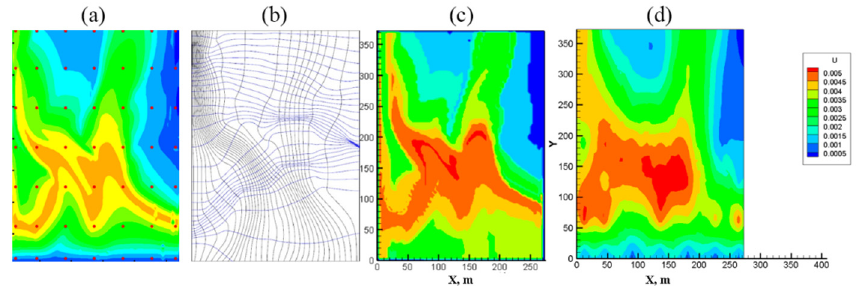
Figure 14. Interpolation results based on real filtration data (a) synthetic deposit; (b) streamline and time of flight-based grid; (c) streamline-based interpolation; (d) ordinary kriging-based interpolation with SGeMS software.